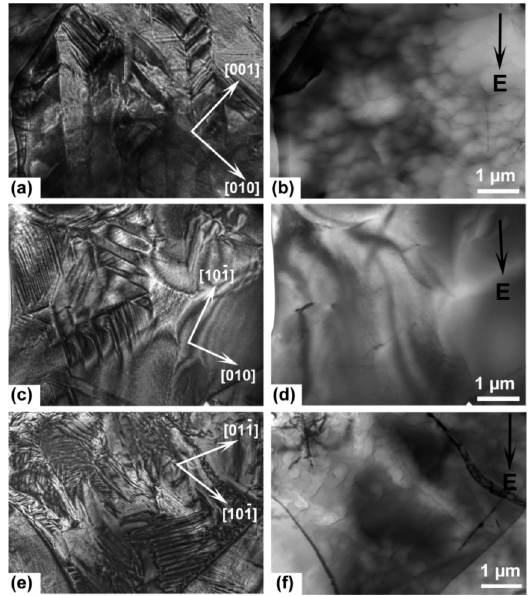
Figure 14. In situ TEM observations of a series of grains in the same specimen of the 0.5Ba(Zr 0.2 Ti 0.8 )O 3 –0.5(Ba 0.7 Ca 0.3 )TiO 3 ceramic. ( a , c , e ) show the virgin state of domain patterns; ( b , d , f ) bright-field micrographs are compared with different electric field conditions [83].